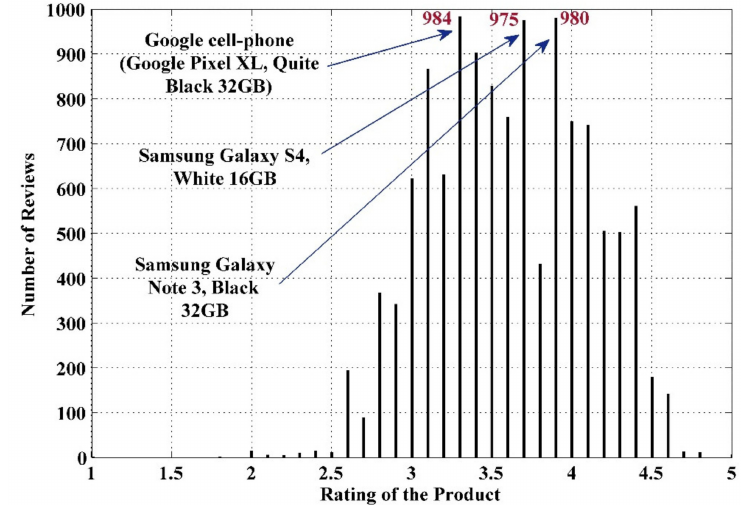
Figure 8. Rating wise number of maximum reviews of the products in the market.